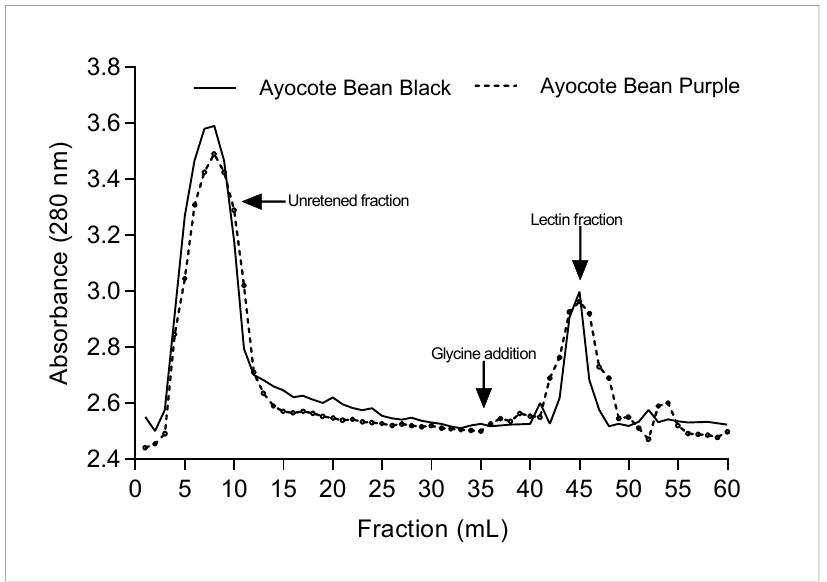
Table 1. Purification table of the lectin from two varieties of Phaseolus coccineus. Hemagglutination activity/mg of protein.